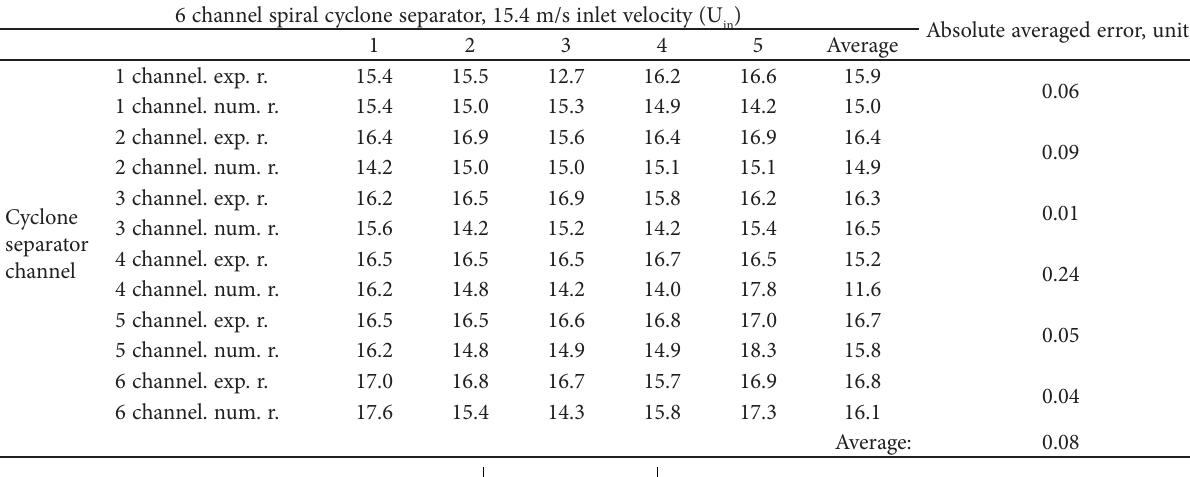
Table 2. Change of velocity (experimental and modelling) in cyclone separator channels of spiral corps depending on the position and geometry of curvilinear semi-rings ( U = 15.4 in